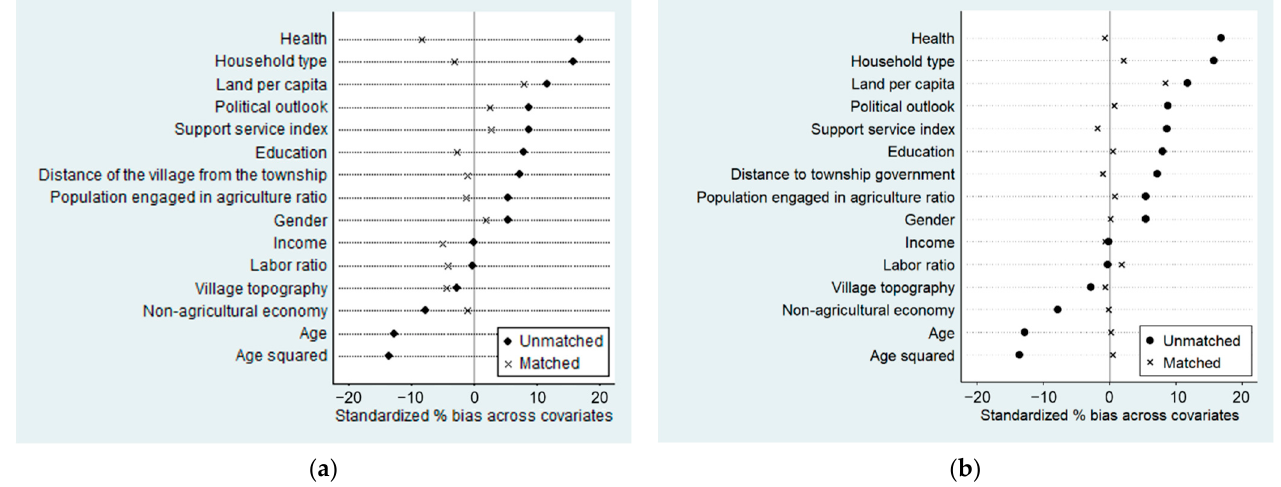
Figure 4. Standardized % bias across covariates: ( a ) with nearest neighbor matching; ( b ) with kernel-based matching.